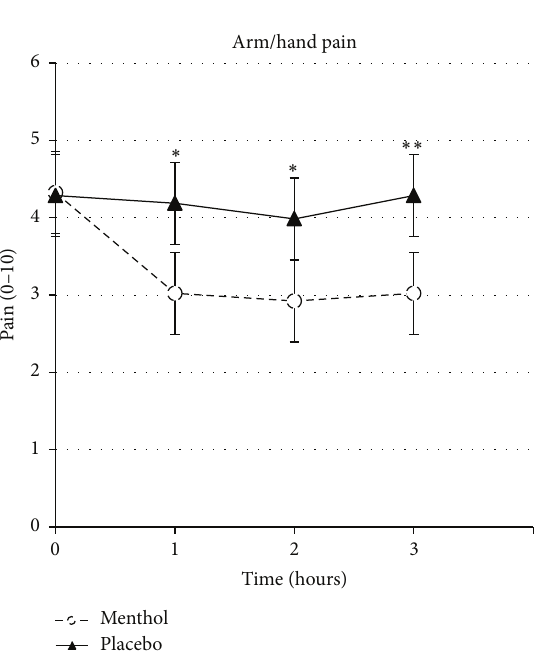
Figure 2: Change in arm/hand pain following application of topical menthol (menthol) or topical placebo (placebo) before (time 0) and 1, 2, and 3 hours following application. ∗ , ∗∗ denotes significant difference between interventions ( 𝑃 < 0.05 ; 𝑃 < 0.01 ,